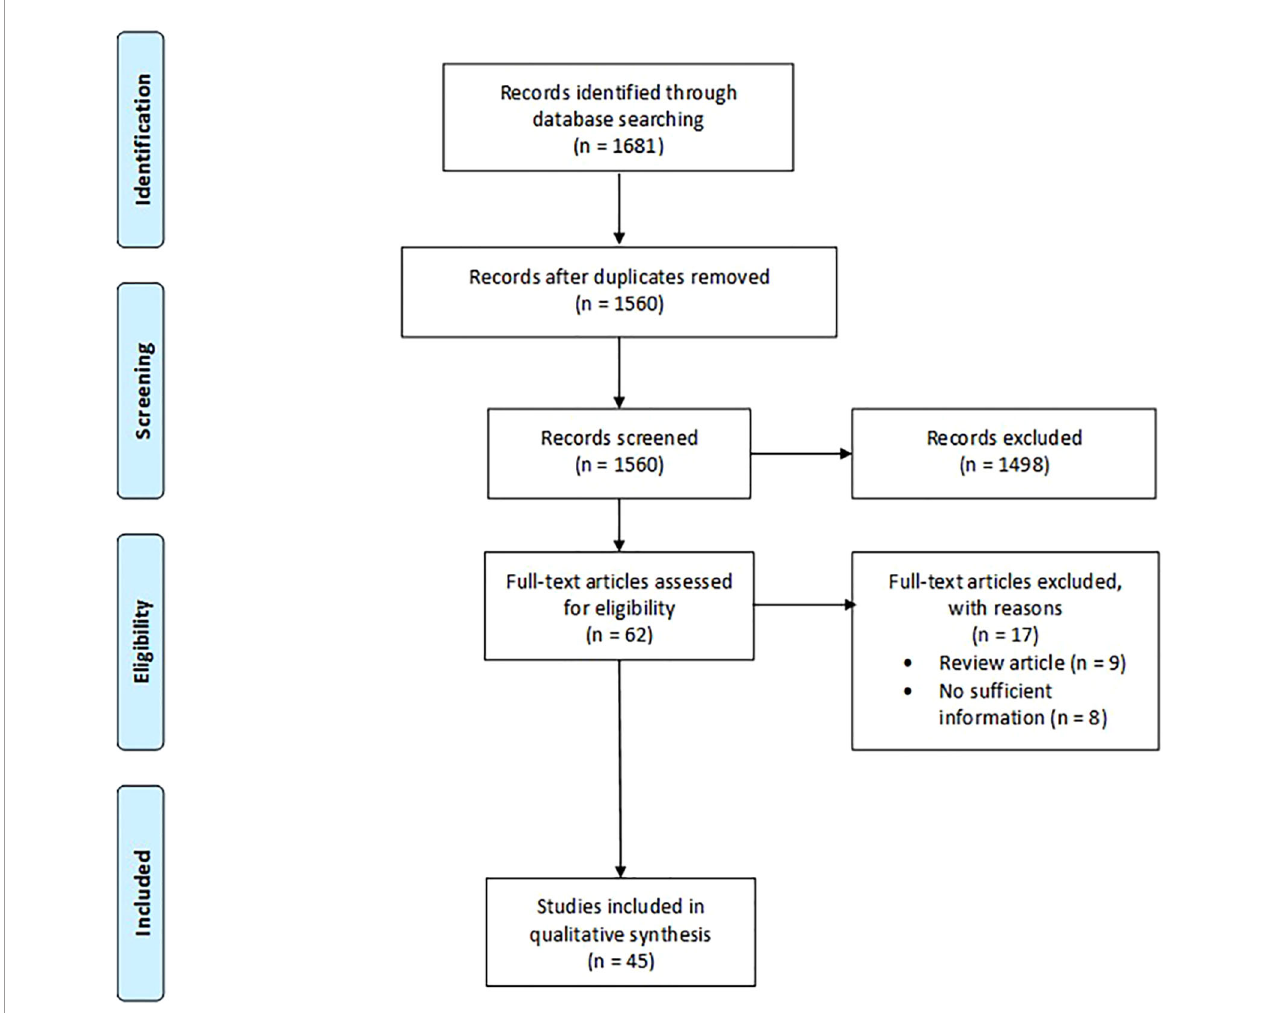
FIGURE 1 | Search fl ow diagram. The diagram was designed according to the template of the PRISMA fl ow diagram from Page et al. (12) available at the PRISMA website